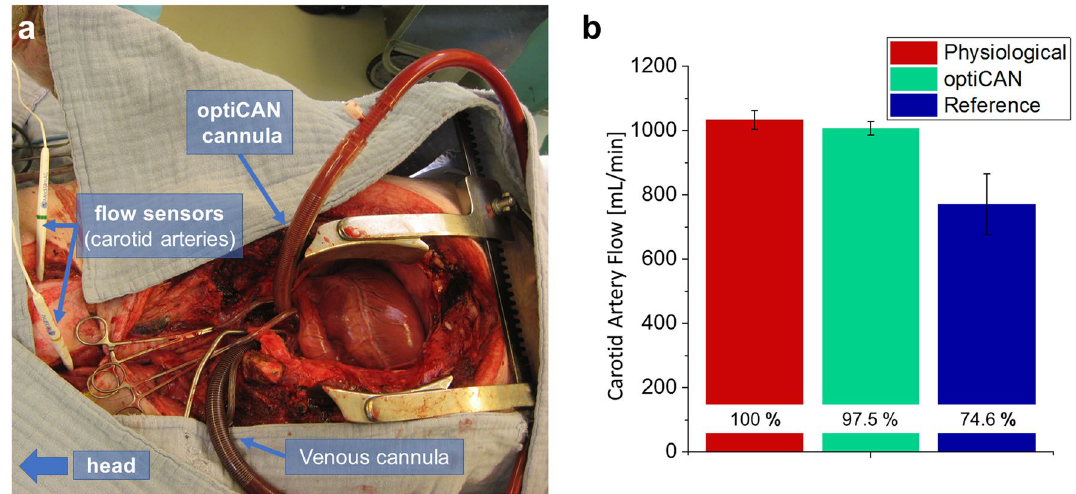
Figure 2. In vivo animal trial in swine during CPB. ( a ) The cerebral flow through the carotid arteries was measured using two flow sensors. ( b ) Comparison of the absolute carotid flow provided by reference and optiCAN cannula and the physiological flow without CPB.